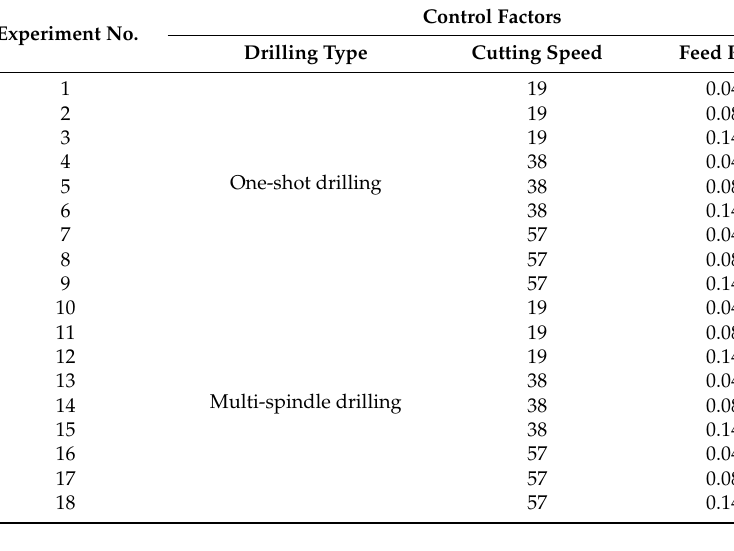
Table 3. Experimental layout with control